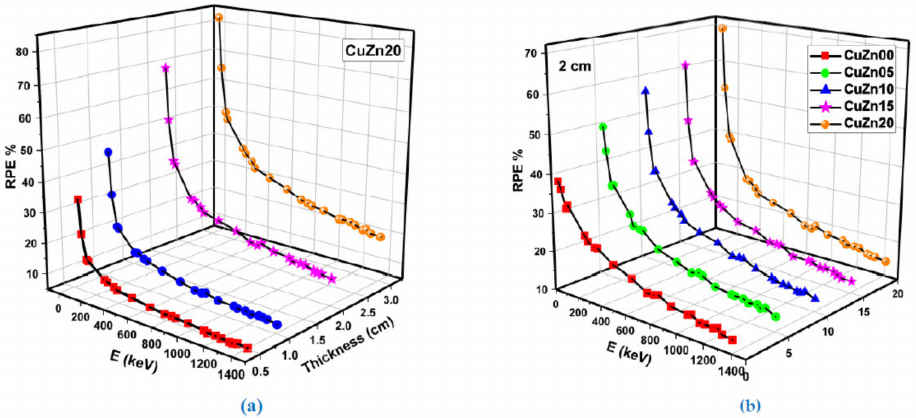
Figure 17. ( a ) Radiation protection efficiency (RPE) of CuZn20 sample at different thicknesses ( b ) Radiation protection efficiency (RPE) of fabricated composites at 2